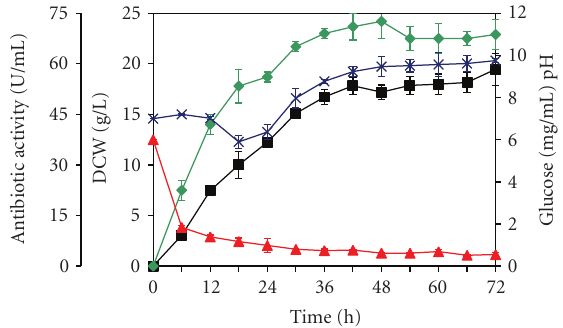
Figure 2: Time-course data of batch fermentation in 5-L fermenter with initial pH at 7.0: dry cell weight (DCW) ( ( ); glucose ( ); and pH ( × (cid:2) (cid:3)